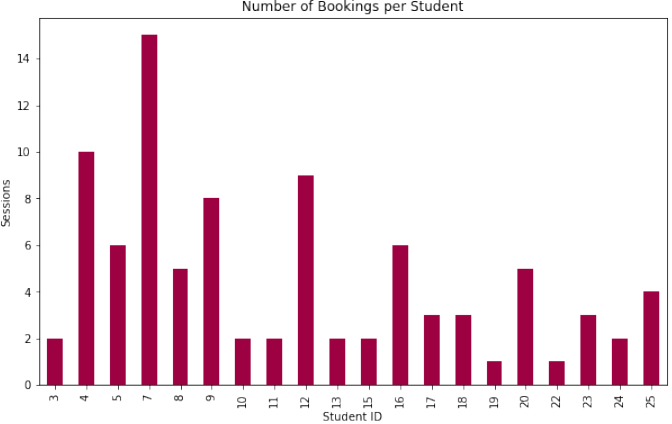
Figure 5. Number of Bookings per